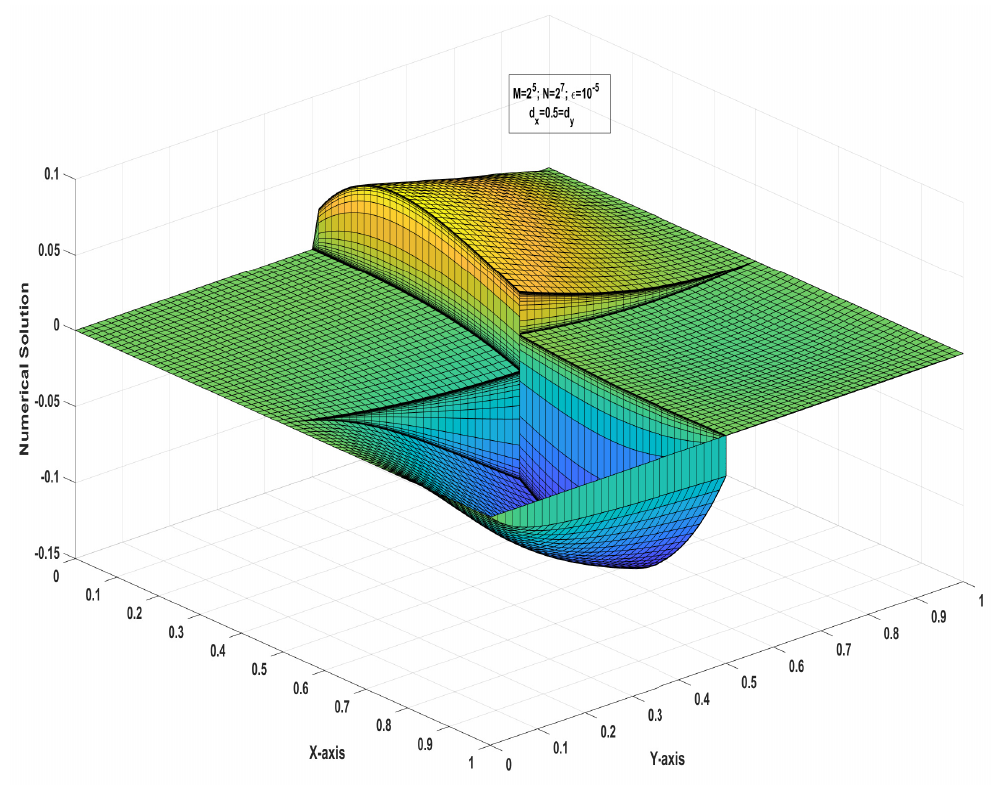
Figure 2. Numerical solution of Example 1 for fixed M = 2 5 , N = 2 7 , ε = 10 − 5 .